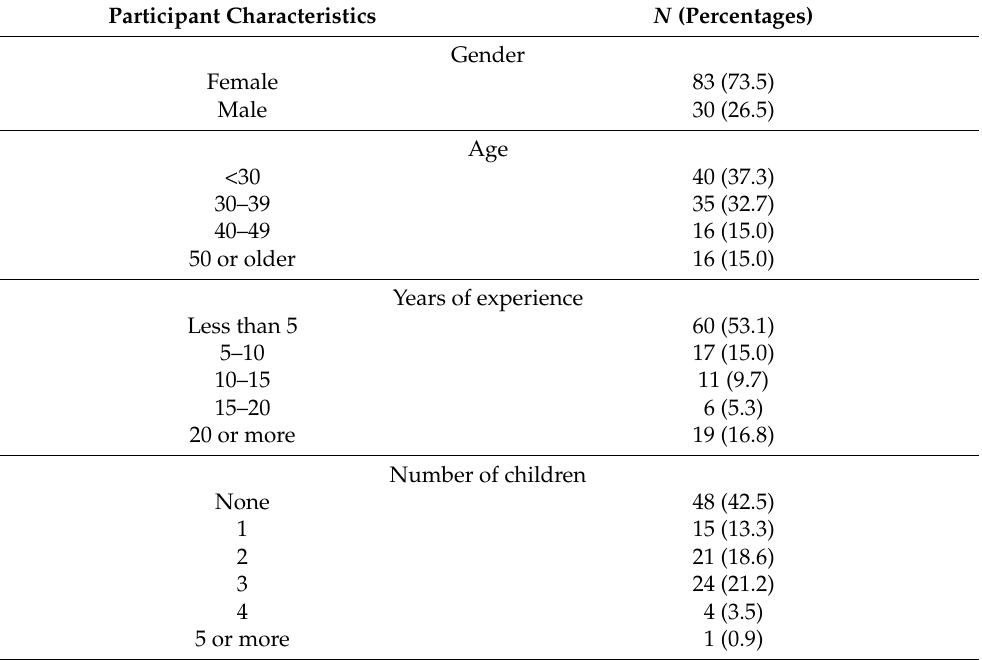
Table 1. Socio-demographic characteristics of participants ( N =